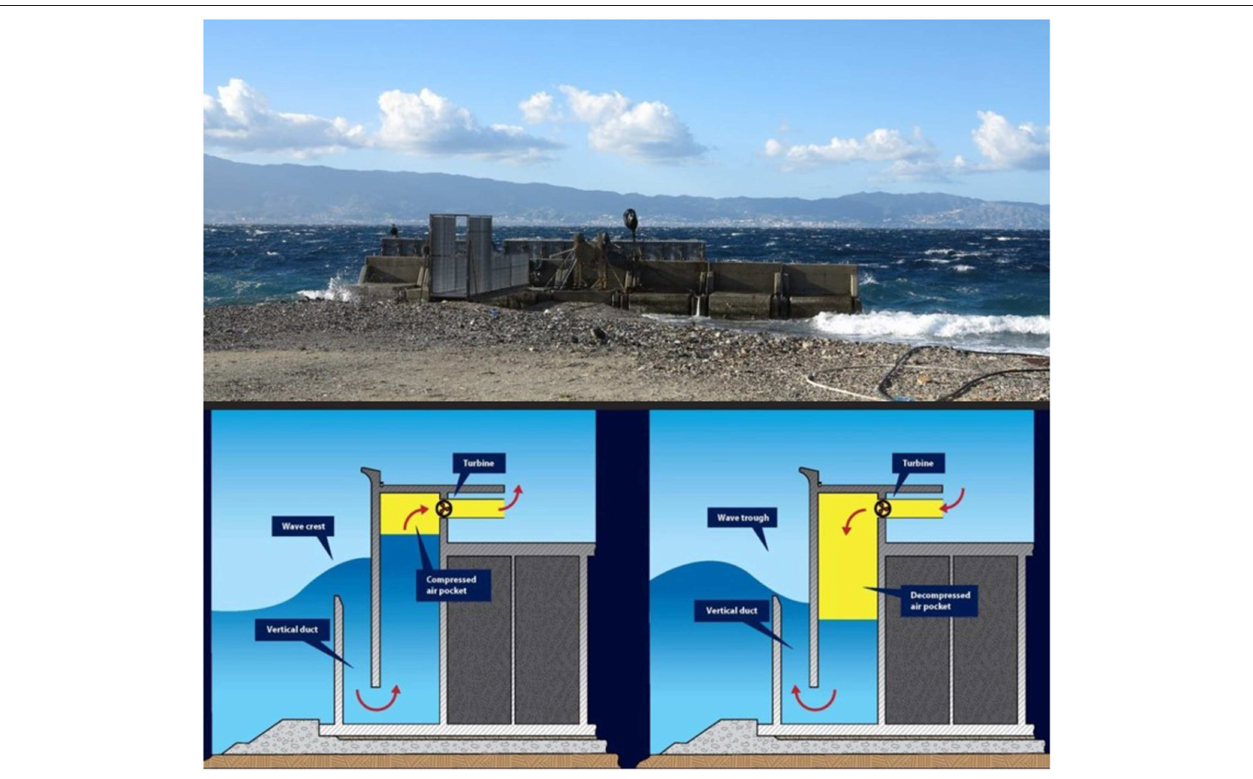
FIGURE 3 | 10 REWEC3 scale device ( Top —from www.noel.unirc.it) and schematic representation of REWEC3 (Bottom) .